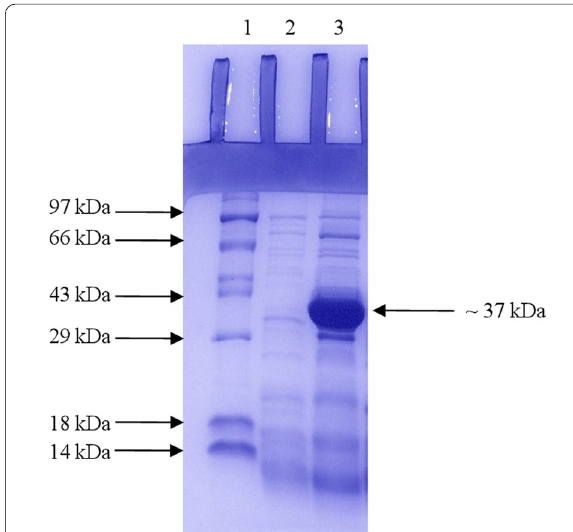
Fig. 2 Induction of pET32a /allatotropin clone analyzed on 12% + SDS PAGE. Lane 1—Protein marker, Lane 2—Uninduced sample, Lane